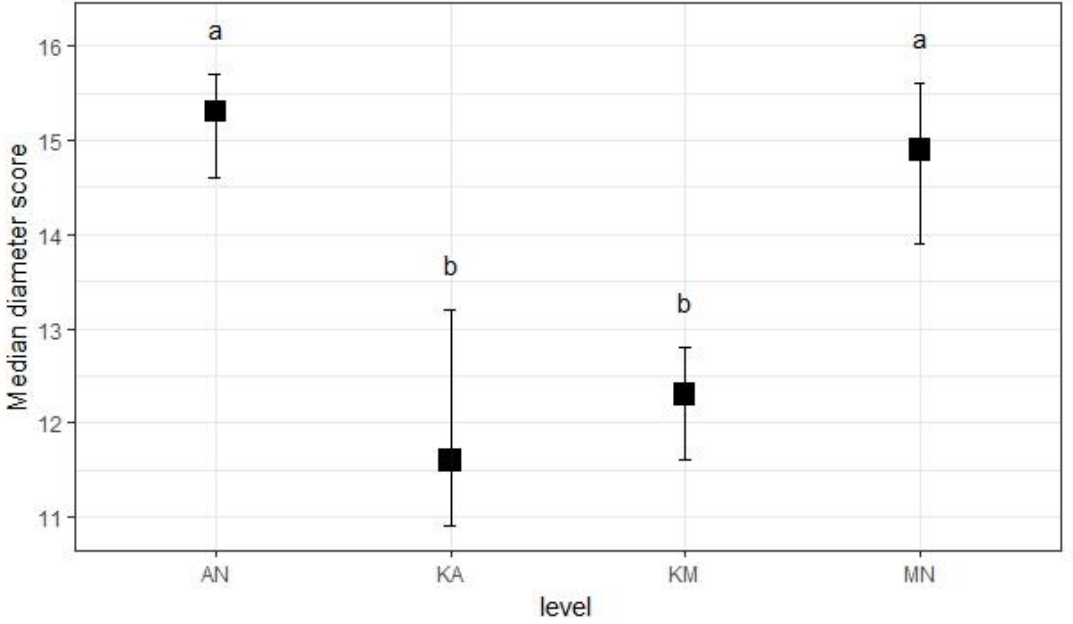
Figure 12. Results of Wilcoxon rank sum test on tree diameter under two different treatments, i.e., agroforestry and monoculture, for nyamplung and kemiri sunan (AN—agroforestry nyamplung; KA—agroforestry kemiri sunan; KM—monoculture kemiri sunan; and, MN—monoculture nyamplung). The letters a and b on the figure show different performance levels of diameter.